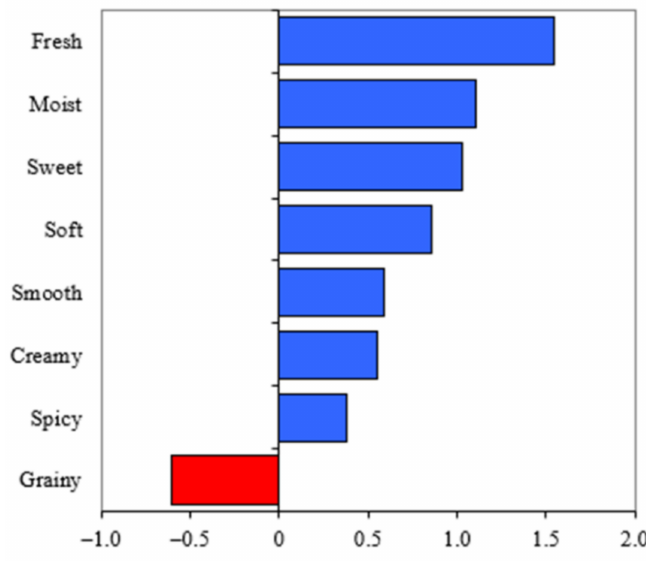
Figure 2. Attribute mean impact on overall liking for ten nutrient-dense foods derived from penalty analysis ( α = 0.05).